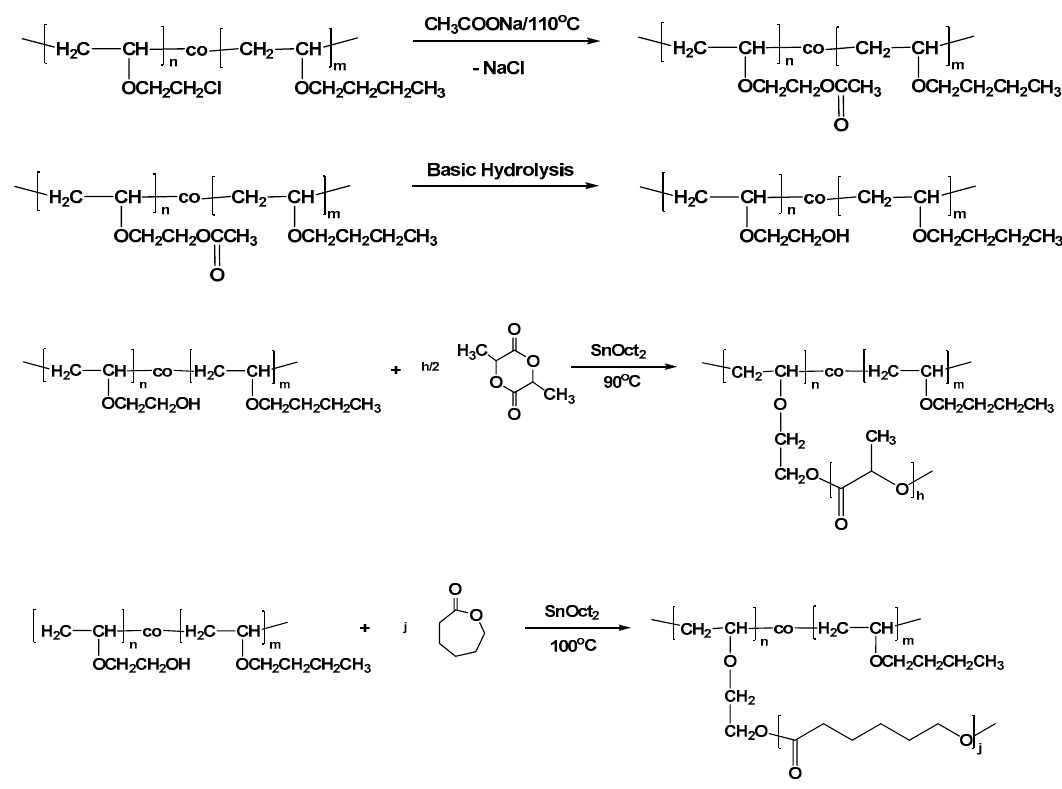
Table 7. Moecular characteristics of the graft copolymers prepared via the grafting “from”